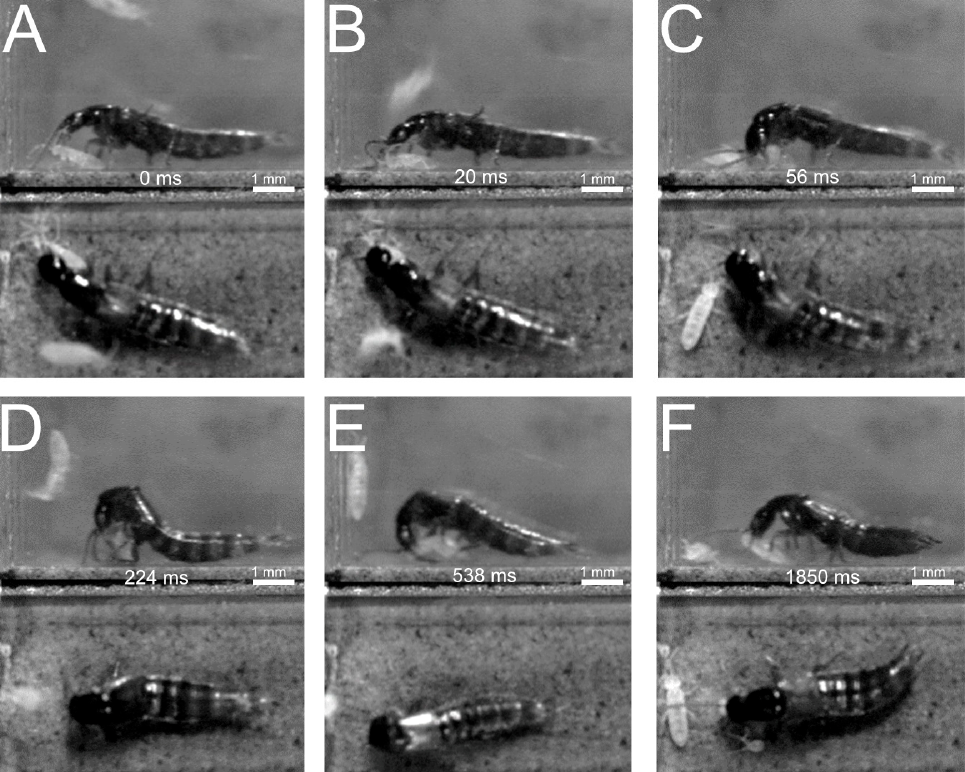
Figure 21. Bisnius sordidus . Formation of a catching basket, i.e., shoving the prey (with the head, the mandibles and/or the front legs) beneath the pronotum and between the inner sides of the front legs to form a cage-like structure that encloses the prey (lateral and dorsal aspects). Time course of depicted sequence is provided in milliseconds elapsed from the start (= image A ). Images B – F depicting the process of prey capture. For further description see text. Source: [47].